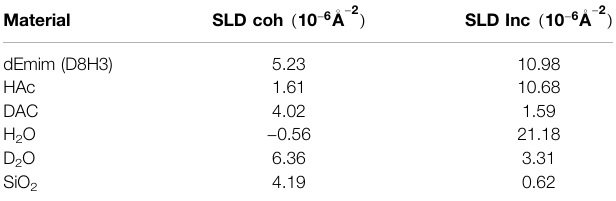
TABLE 1 | Samples used in this study and corresponding scattering length densities, assuming a density of 1.027 g/cm 3 for EmimAc and 2.65 g/cm 3 for the solid phase of the porous glass. SLDs were calculated with Calculator